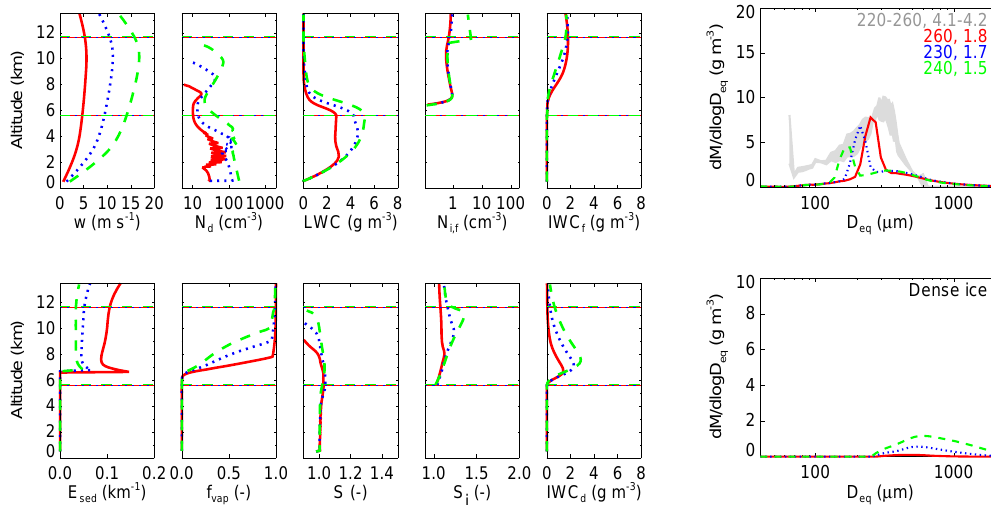
Figure 16. Processes and panels as in Fig. 15, for simulations with entrainment rate of 0.1km − 1 and baseline updraft strength scaled by factors of 0.5 (red solid line), 1.0 (blue dotted line), and 1.5 (green dashed line).